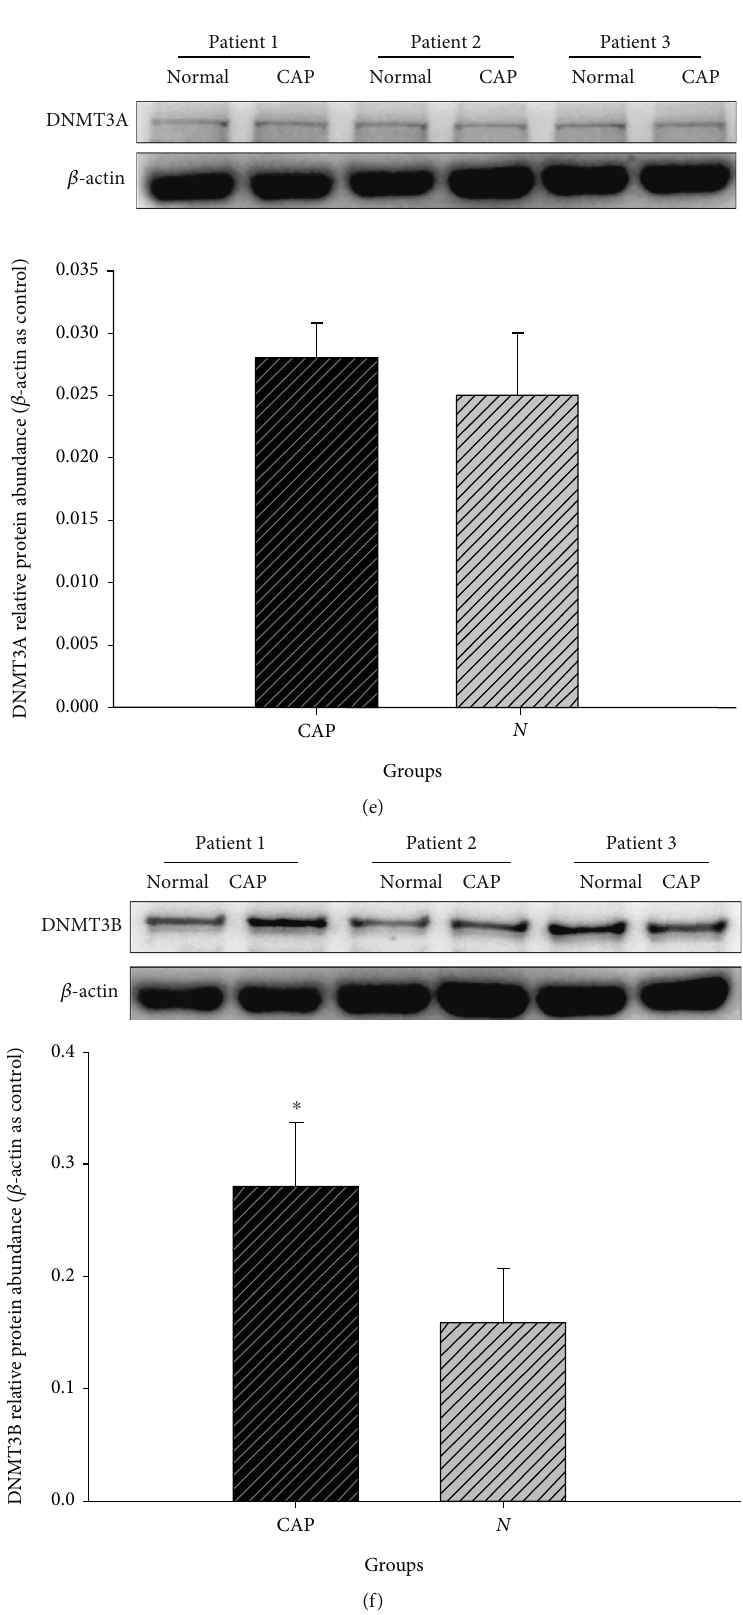
Figure 1: The analysis of DNMT expression levels in CAP and NCM tissues.The relative expression for the mRNA of DNMT1 (a), DNMT3A (b), and DNMT3B (c). The relative protein level for DNMT1 (d), DNMT3A (e), and DNMT3B (f) determined by western blotting protein. ( ∗ P < 0 : 05